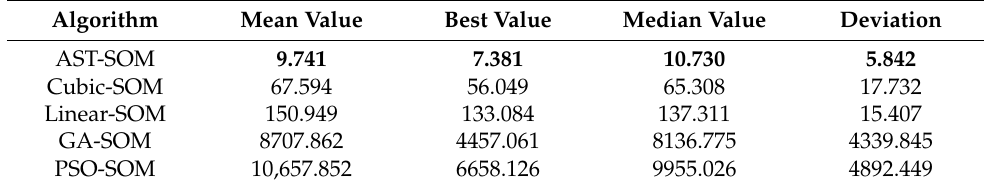
Table 9. The results of all comparative methods with ten independent runs.